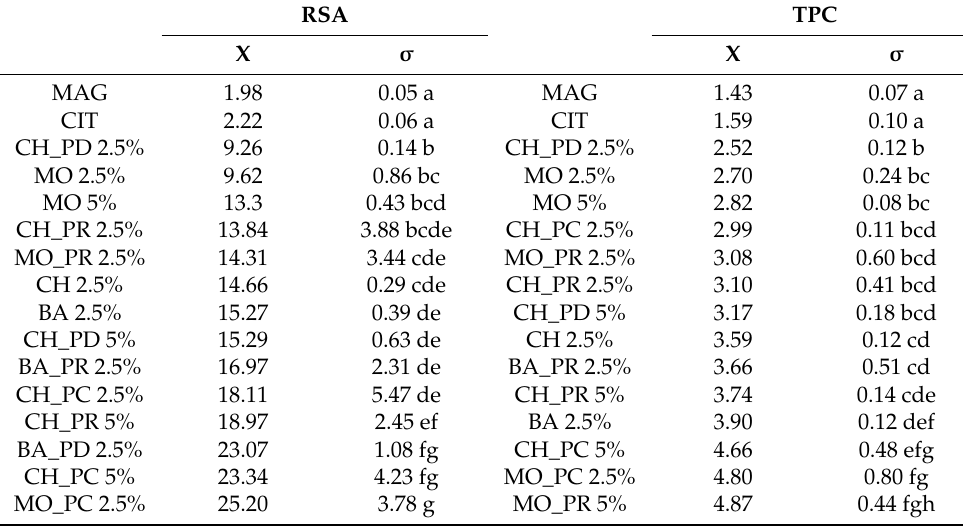
Table 6. Values (X—mean; σ —standard deviation) of radical scavenging activity (RSA; µ mol TE/g) and polyphenolic content (TPC; mg GAE/g) of tofu obtained with the traditional and innovative coagu- lants at two concentrations (2.5% and 5%) and results of variance analysis with post hoc Duncan’s